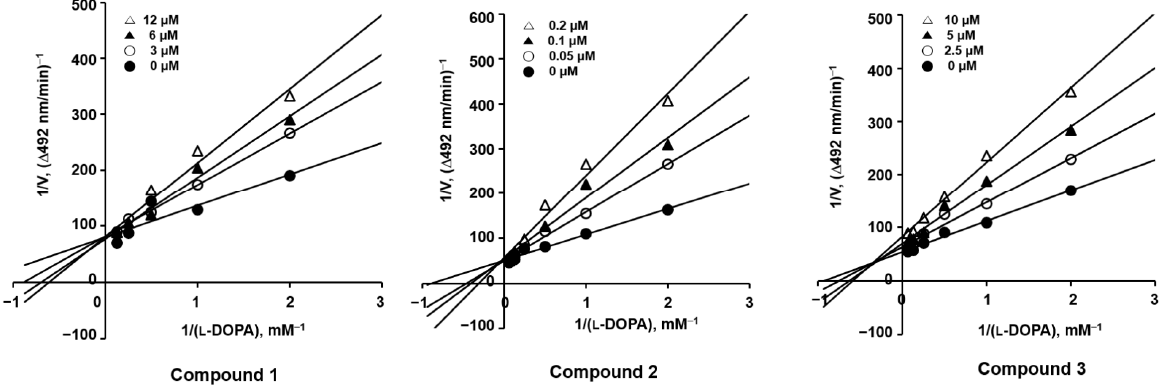
Figure 2. Lineweaver–Burk plots for the inhibition of mushroom tyrosinase activity by ( Z )-BPT derivatives 1 – 3 . The inhibition modes of ( Z )-BPT derivatives 1 – 3 were demonstrated by the analysis of Lineweaver–Burk plots. Three independent experiments with five different concentrations (0.5, 1, 2, 4, and 8 mM) of an L -DOPA substrate were used to measure the augmented dopachrome optical density per minute at 492 nm. The data are shown as mean values of 1/V (an inverse of that optical density per minute). The ( Z )-BPT derivatives were used at concentrations of 0 (filled circles), 3 (unfilled circles), 6 (filled triangles), and 12 µM (unfilled triangles) for 1 ; 0 (filled circles), 0.05 (unfilled circles), 0.1 (filled triangles), and 0.2 µM (unfilled triangles) for 2 ; and 0 (filled circles), 2.5 (unfilled circles), 5 (filled triangles), and 10 µM (unfilled triangles) for 3 . Each experiment was run independently in triplicates.